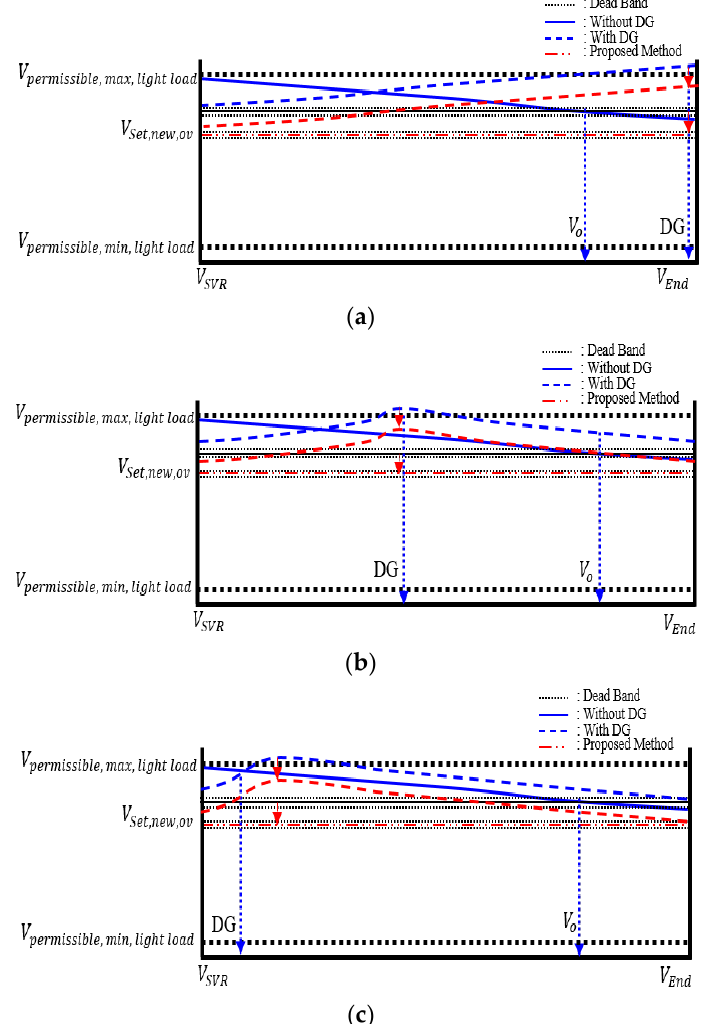
Figure 9. Voltage Profile by proposed SVR tap-control algorithm at light load: ( a ) Case I; ( b ) Case II; ( c ) Case III.